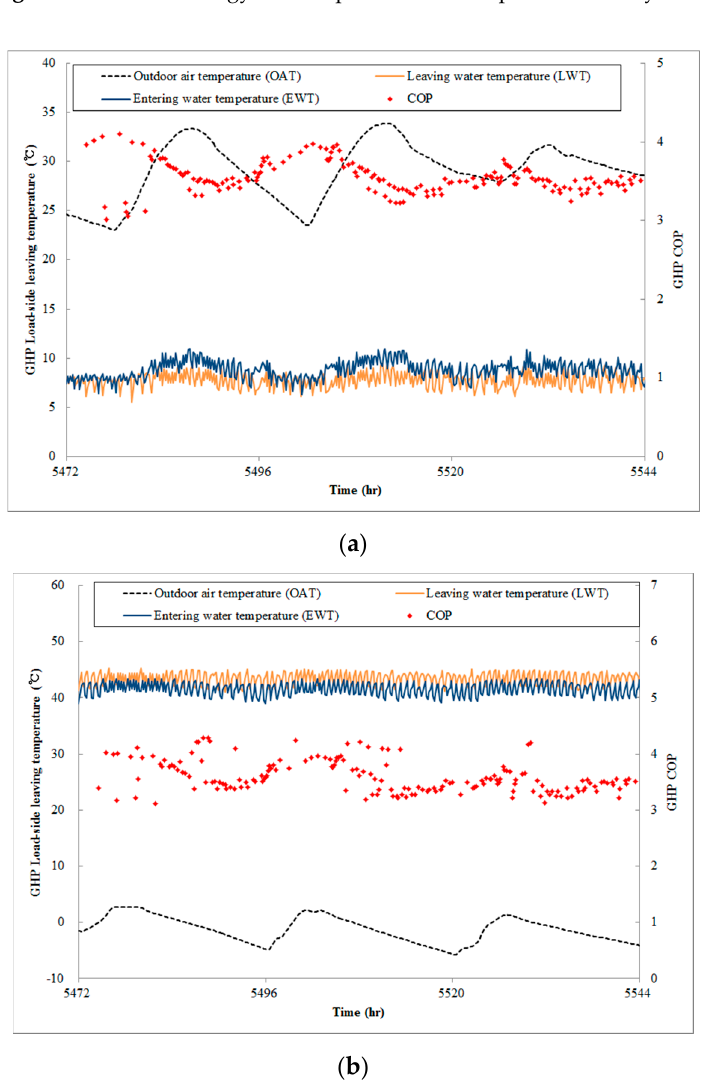
Figure 5. Entering and leaving temperatures and COPs of the existing geothermal heat pump system: ( a ) Summer; ( b ) Winter.